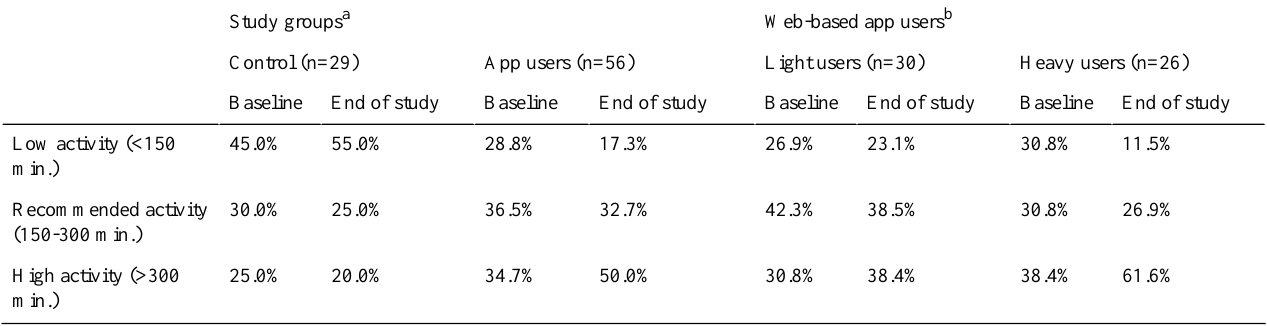
Table 3. Percentage of participants engaging physical activity at different weekly durations.